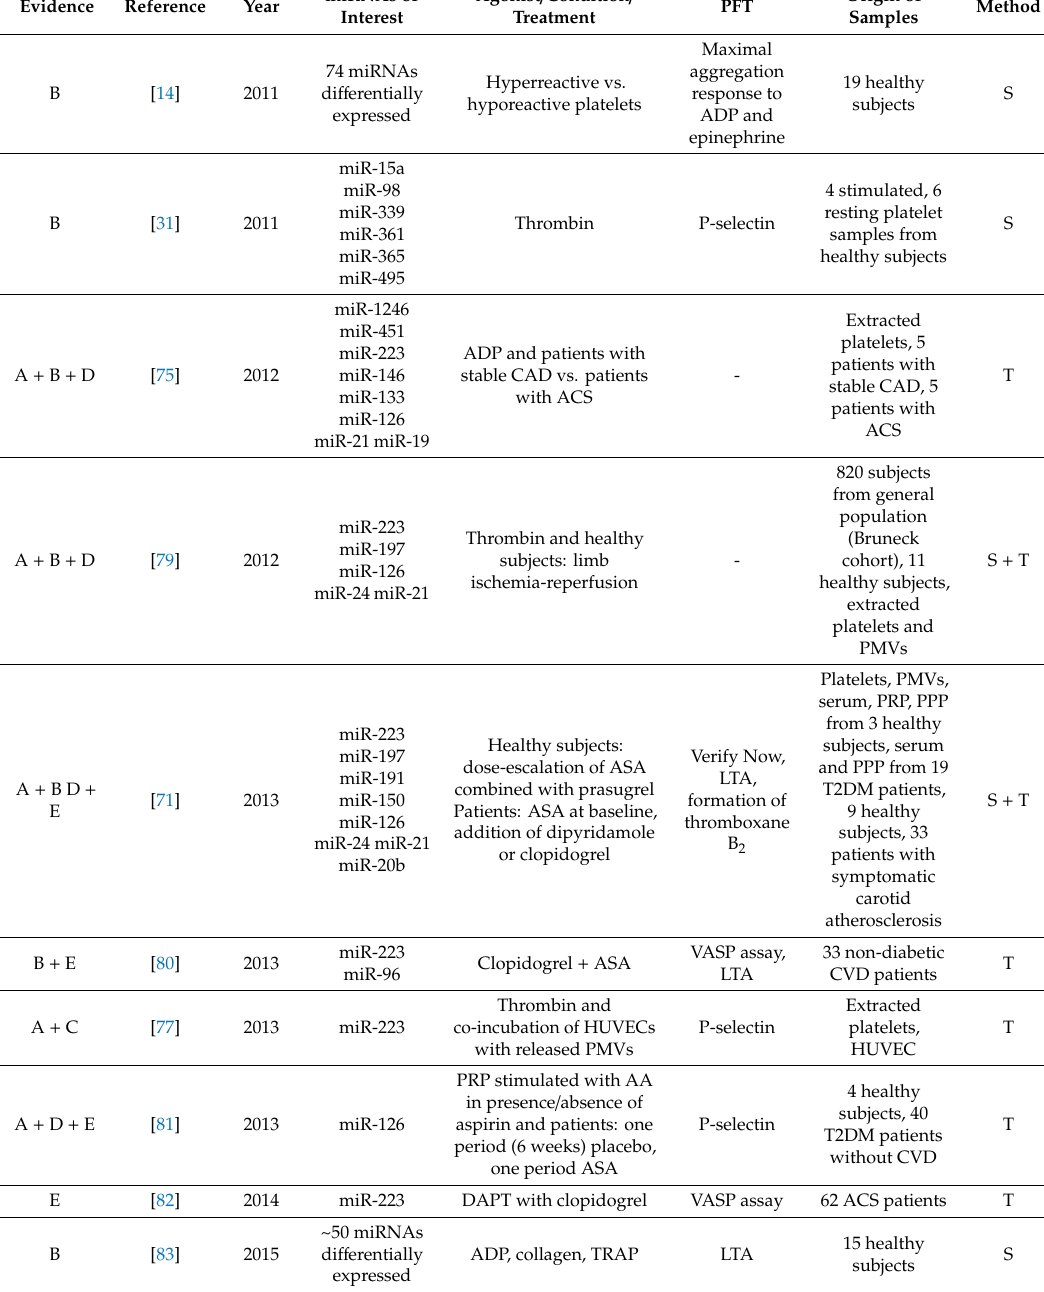
Table 1. Studies investigating the association between platelet and / or circulatory miRNA levels and platelet